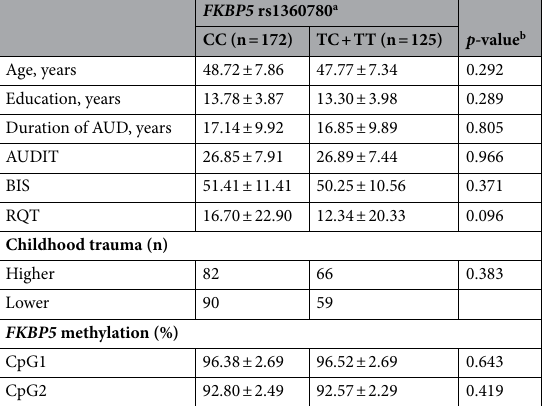
Table 1. Descriptive summary of demographic, clinical, and epigenetic characteristics of patients with AUD based on the genotype groups of FKBP5 rs1360780. AUD alcohol use disorder, AUDIT the Alcohol Use Disorders Identification Test, BIS Barratt Impulsiveness Scale, RQT Resilience Quotient Test. a Mean ± standard deviation except for childhood trauma. b Independent t -test or chi-squared